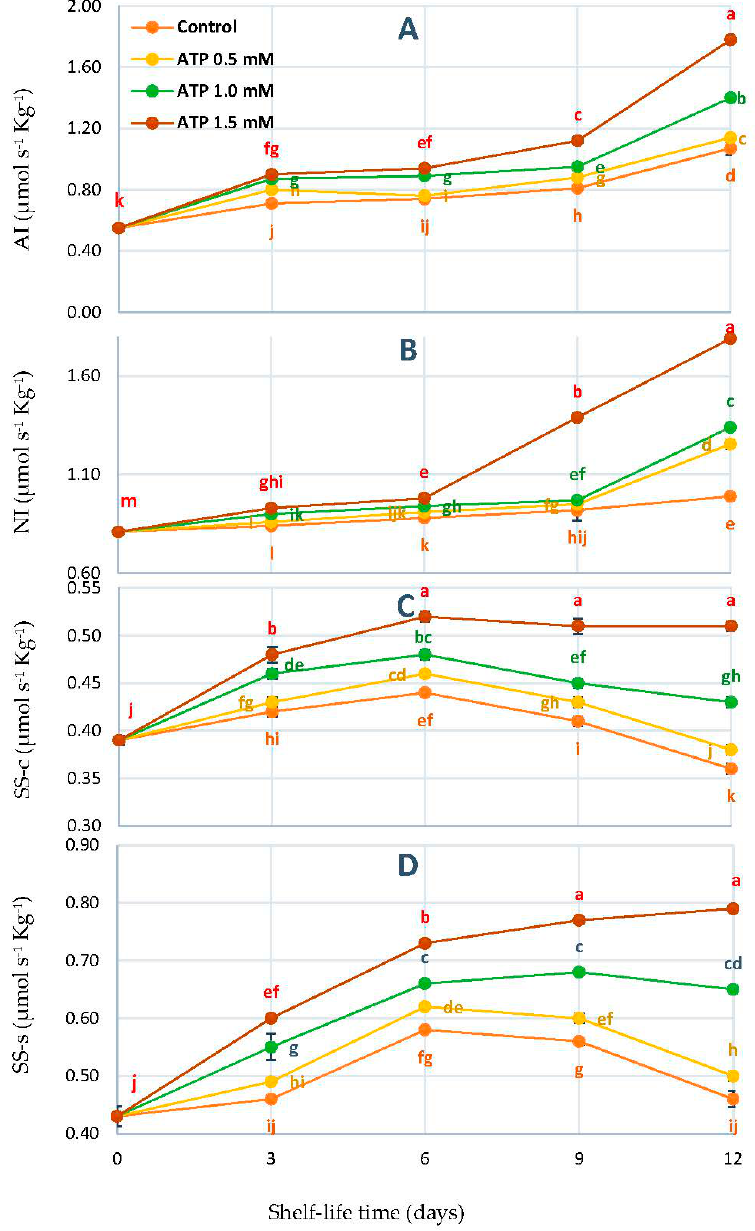
Figure 3. AI ( A ), NI ( B ), SS-c ( C ), and SS-s ( D ) of ‘Zaghloul’ date fruit treated with ATP at different concentrations (0, 0.5, 1.0, and 1.5 mmol L − 1 ) during storage at 27 ± 1 ◦ C, 67 ± 3% R, for 12 d. Each value represents mean ± SE ( n = 3). The letters differ ( p < 0.05) and represent the significance between treatments using the Tukey–Kramer HSD test to compare the different